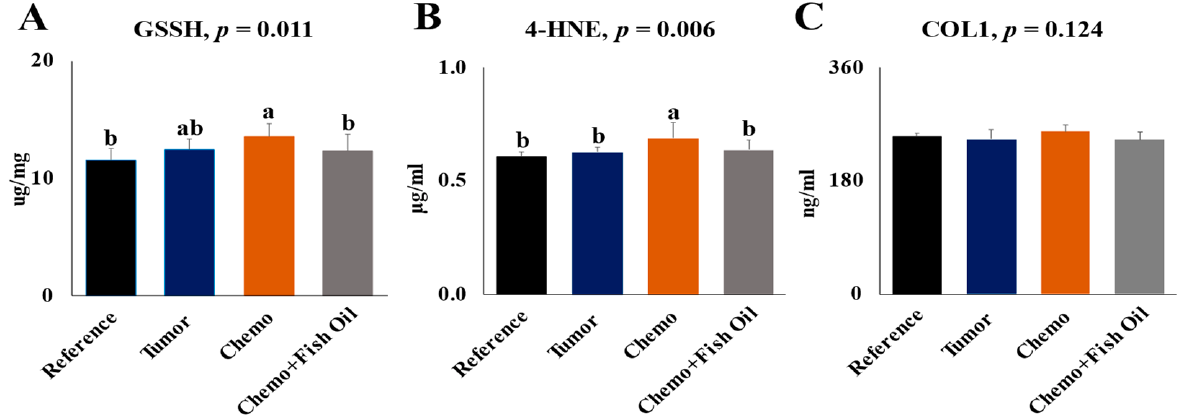
Figure 2. Liver-oxidized glutathione, GSSH ( A ); 4-Hydroxy-2-Nonenal, 4-HNE ( B ); type-I collagen, COL-1 ( C ). Values are expressed as mean ± SD. Significant differences were determined using one- way ANOVA. Post hoc analysis was carried out by Duncan multiple-comparison tests for simple effect when interactions were present or when the Kruskal–Wallis test indicated the presence of differences. Differing lower-case superscript letters indicate significant simple-effect differences between values (a > b). Groups: Reference, healthy rats that did not undergo tumor implantation nor receive chemotherapy, consumed control diet only; Tumor, tumor-bearing animals that did not receive chemotherapy, consumed control diet only; Chemo, tumor-bearing animals that received chemotherapy, consumed control diet only; Chemo+Fish Oil, tumor-bearing animals that received chemotherapy, consumed fish oil diet.